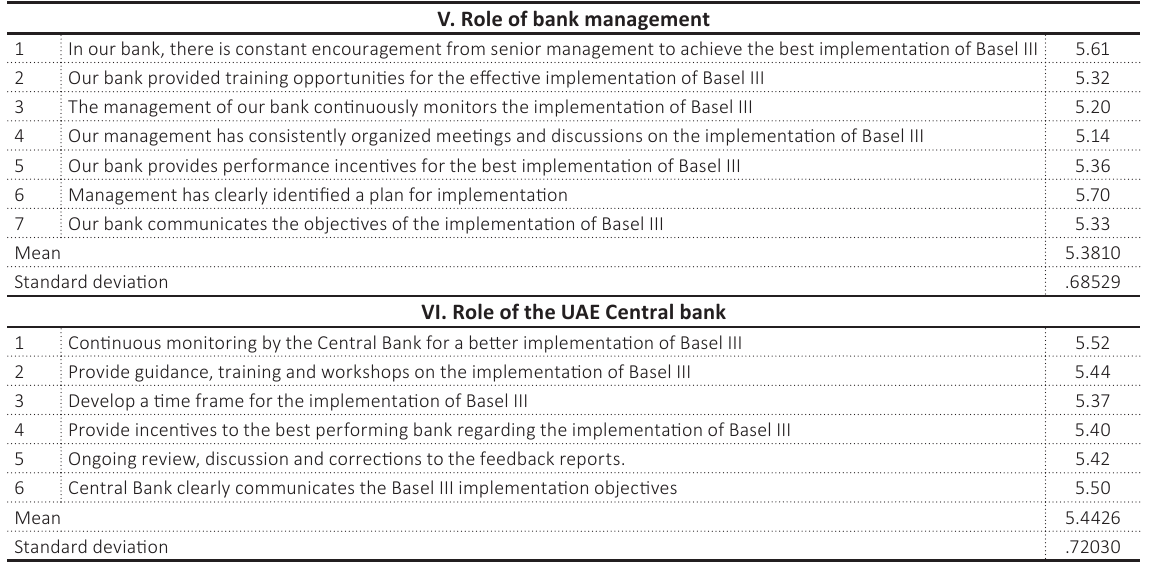
Table 4 (cont.). Classification of the factors in each category